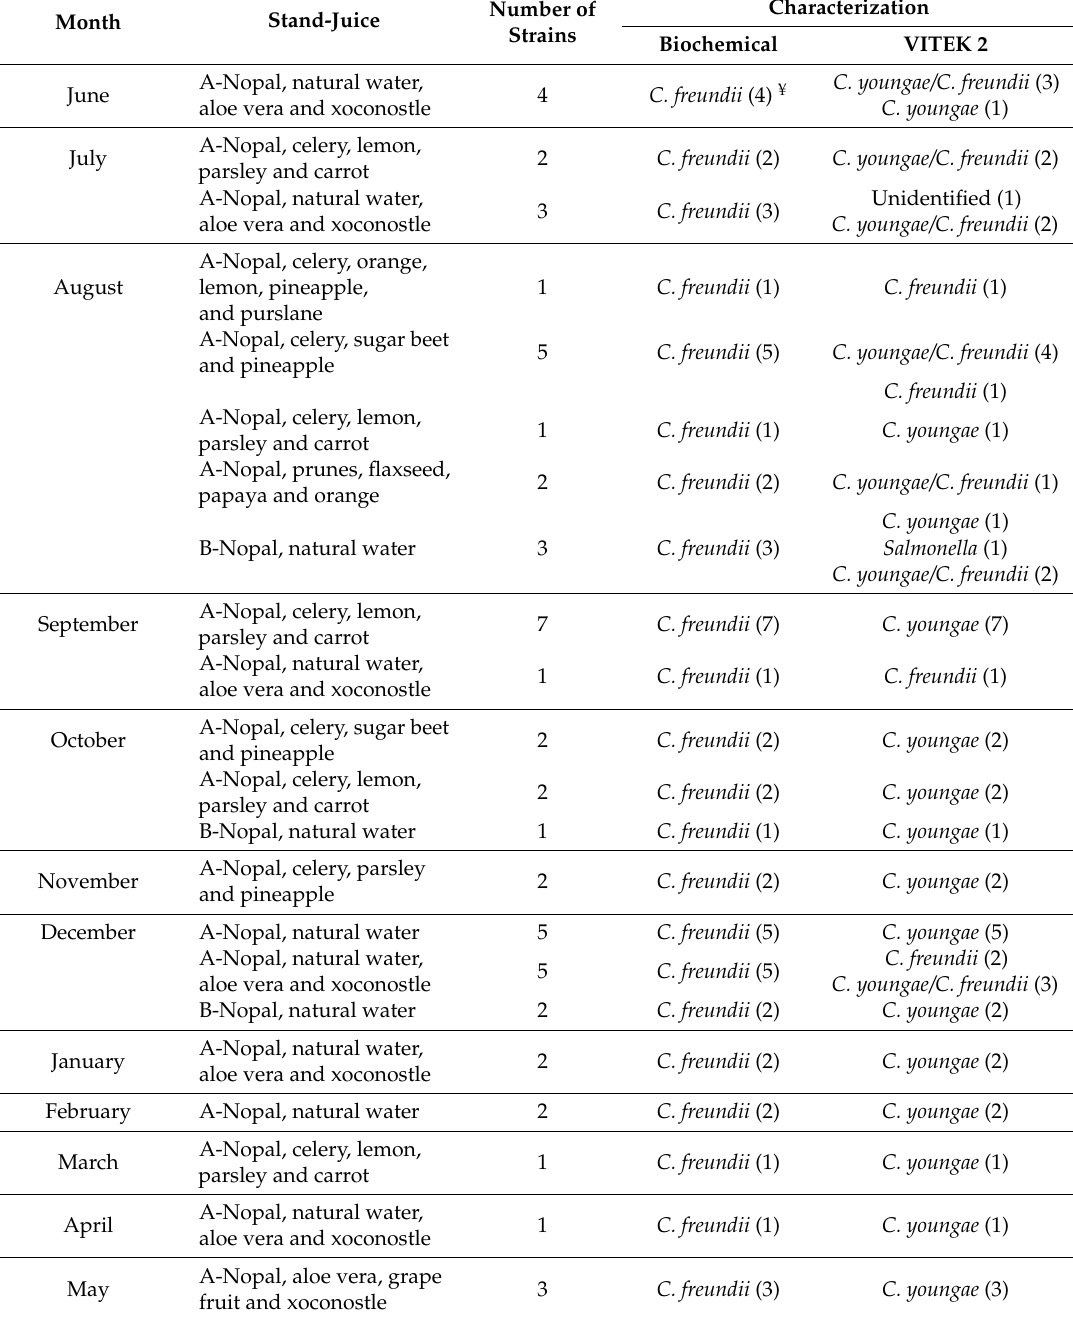
Table 3. Biochemical characterization of presumptive Salmonella strains isolated from nopal